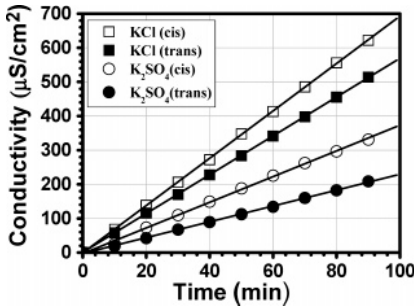
Figure 6. Ion permeability of porous alumina membranes coated with LbL films under UV light (open circles and squares) and in the dark (filled circles and squares) measured by conductivity. Reprinted with permission from Ref. [75]. Copyright 2008 American Chemical Society.